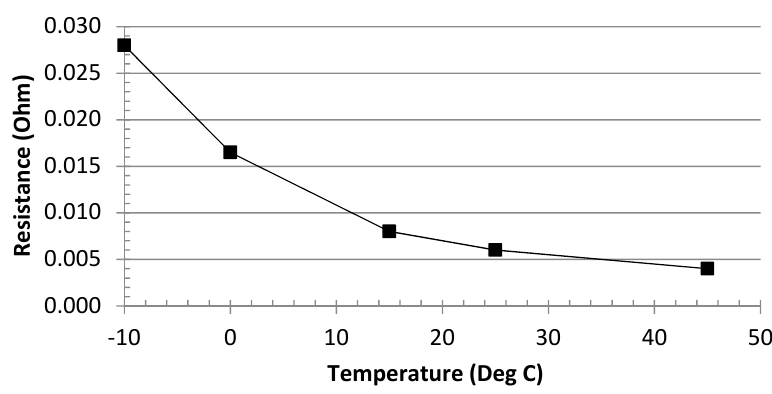
Figure 5. Li-ion cell resistance as a function of temperature [4].